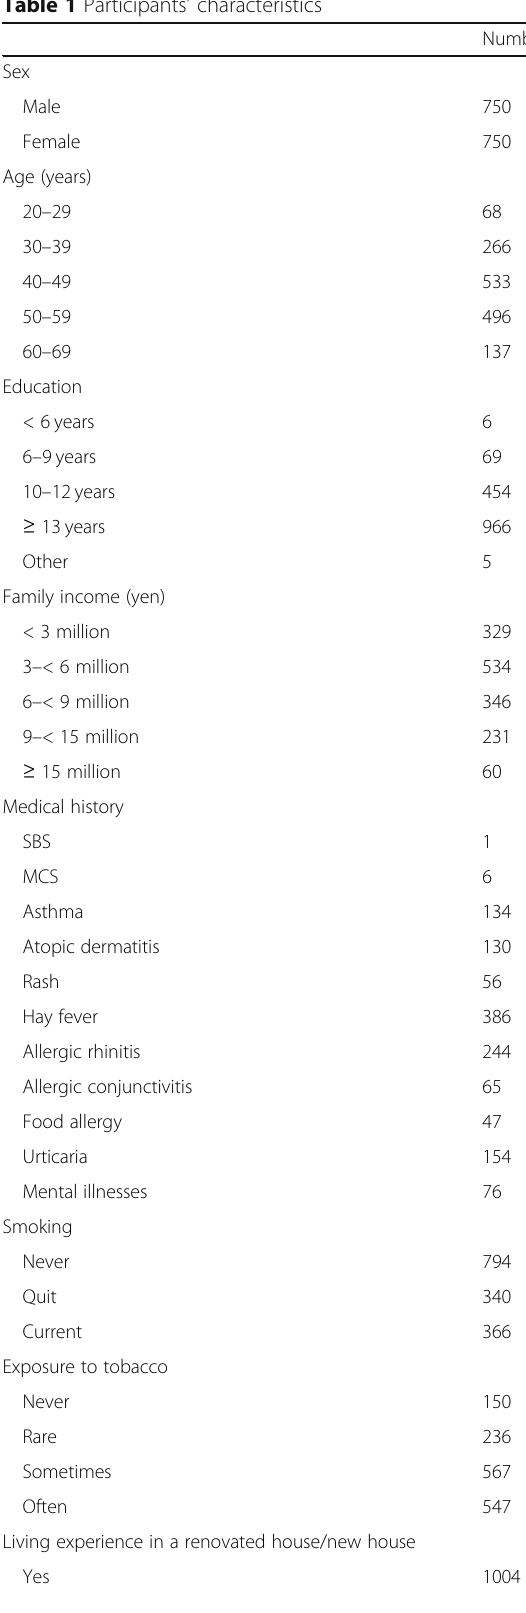
Table 1 Participants ’